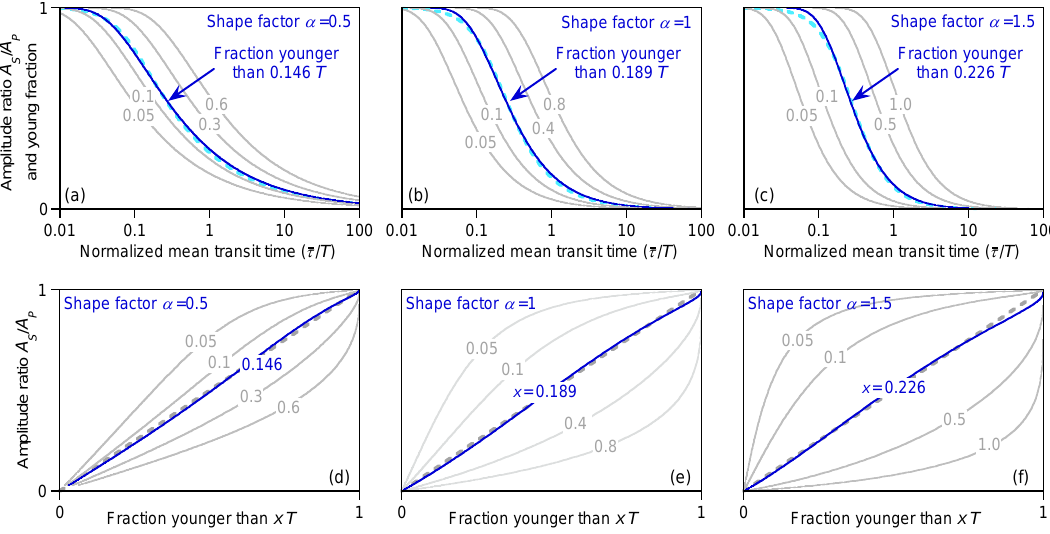
Figure 9. (a) – (c) show the amplitude ratios A S /A P in precipitation and streamflow tracer cycles (light blue dashed line) as function of mean transit time τ , compared to the fraction of water younger than several threshold ages (gray lines), and the best-fit age threshold (dark blue line). (d) – (f) show the relationship between amplitude ratio and the fraction of water younger than several age thresholds (gray lines) and the best-fit age threshold (dark blue line), with the 1:1 line (dashed gray) for comparison. Panels show results for three different gamma distributions, with shape factors α = 0.5, α = 1, and α = 1.5. Root-mean-squared errors (RMSEs) for amplitude ratios A S /A P as predictors of the best-fit young water fractions are 0.012, 0.011, and 0.015 for (d) – (f) , respectively. In all panels, threshold age and mean transit time are normalized by T , the period of the tracer cycle. For seasonal tracer cycles, T = 1year and thus threshold age and mean transit time are in